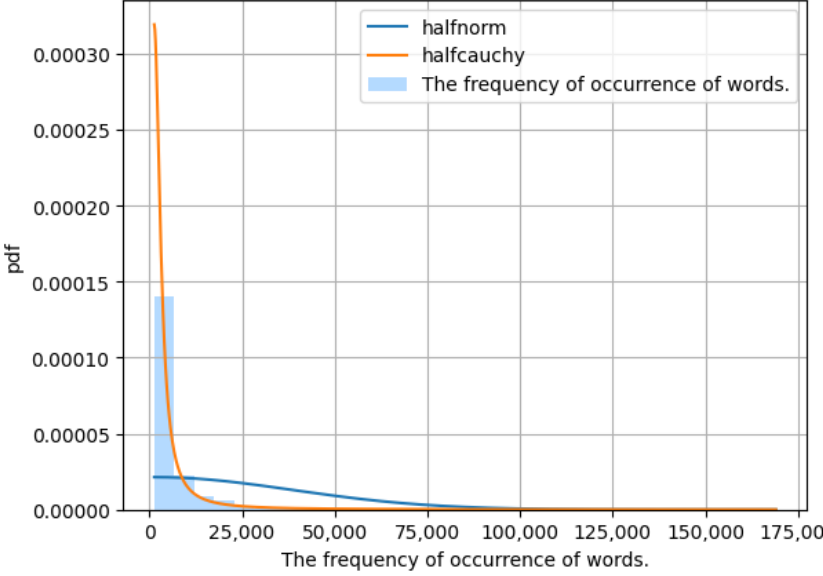
Figure 5. COCO captioning dataset: a chart comparing the frequency of word occurrence in image captions in training